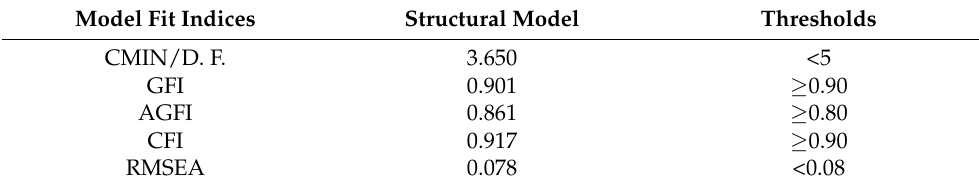
Table 5. Model fitness summary.